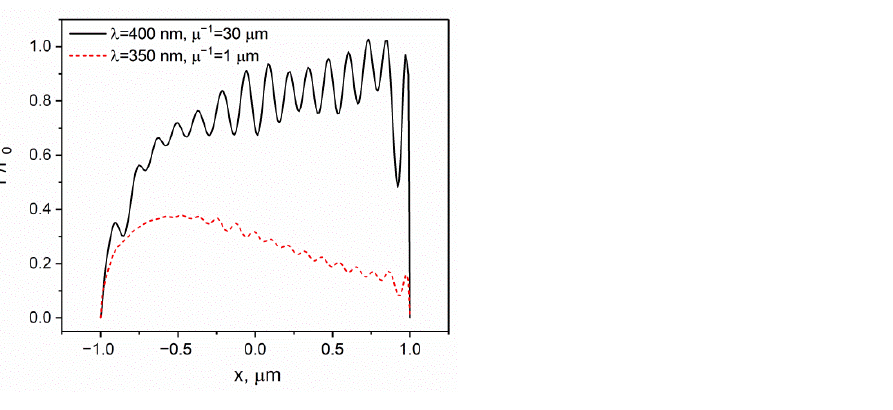
Figure 8. Relative power of radiation incident on vertical sections of a crystal at different depths.